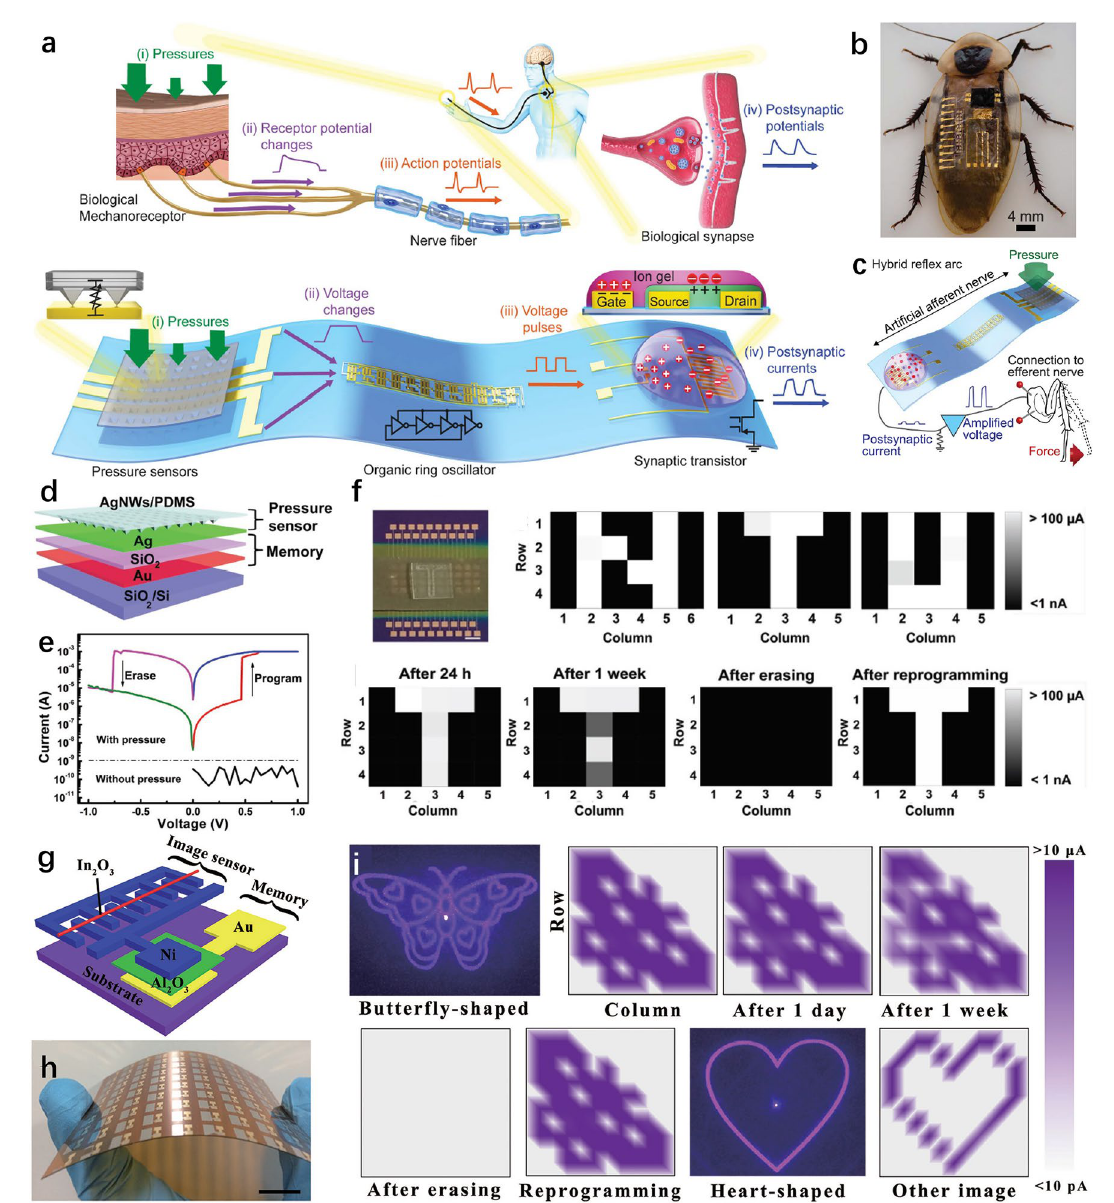
Fig. 32 Biomimetic systems containing soft sensor and neuromorphic devices. a A biological afferent nerve stimulated by pressure and corre- sponding an artificial afferent nerve made of pressure sensors, an organic ring oscillator, and a synaptic transistor. The parts with the same colors in (upper) and (lower) correspond to each other. b Discoid cockroach with an artificial afferent nerve on the back. c Hybrid reflex arc with the artificial afferent nerve. Pressure stimuli from sensors can be converted into postsynaptic currents. Postsynaptic currents are amplified to stimu- late biological nerves and cockroach muscles to initiate movement. Reproduced with permission [378]. Copyright (2018), American Association for the Advancement of Science. d Diagram of the haptic memory device comprising of pressure sensor and memristor. e Typical I–V curves of the integrated device with pressure and without pressure. The device can only be programmed and erased with the pressure applied. f Photo- graph of the mold (letter “T”) put on integrated haptic memory arrays. Scale bar represents 1 mm. Mapping of letters “N”, “T”, and “U”. Only device cells beneath the letters can be programmed. Demonstration of the device arrays to memorize the applied pressure and multicycle usage. Reproduced with permission [381]. Copyright (2016), Wiley–VCH. g Diagram of the bioinspired visual memory unit consisted of an image sensor and a memristor. h Photograph of the integrated devices arrays on soft PI substrates. Scale bar represents 1 cm. i Information storage per- formance and effective reusability of the soft visual memory device arrays. Reproduced with permission [382]. Copyright (2018),